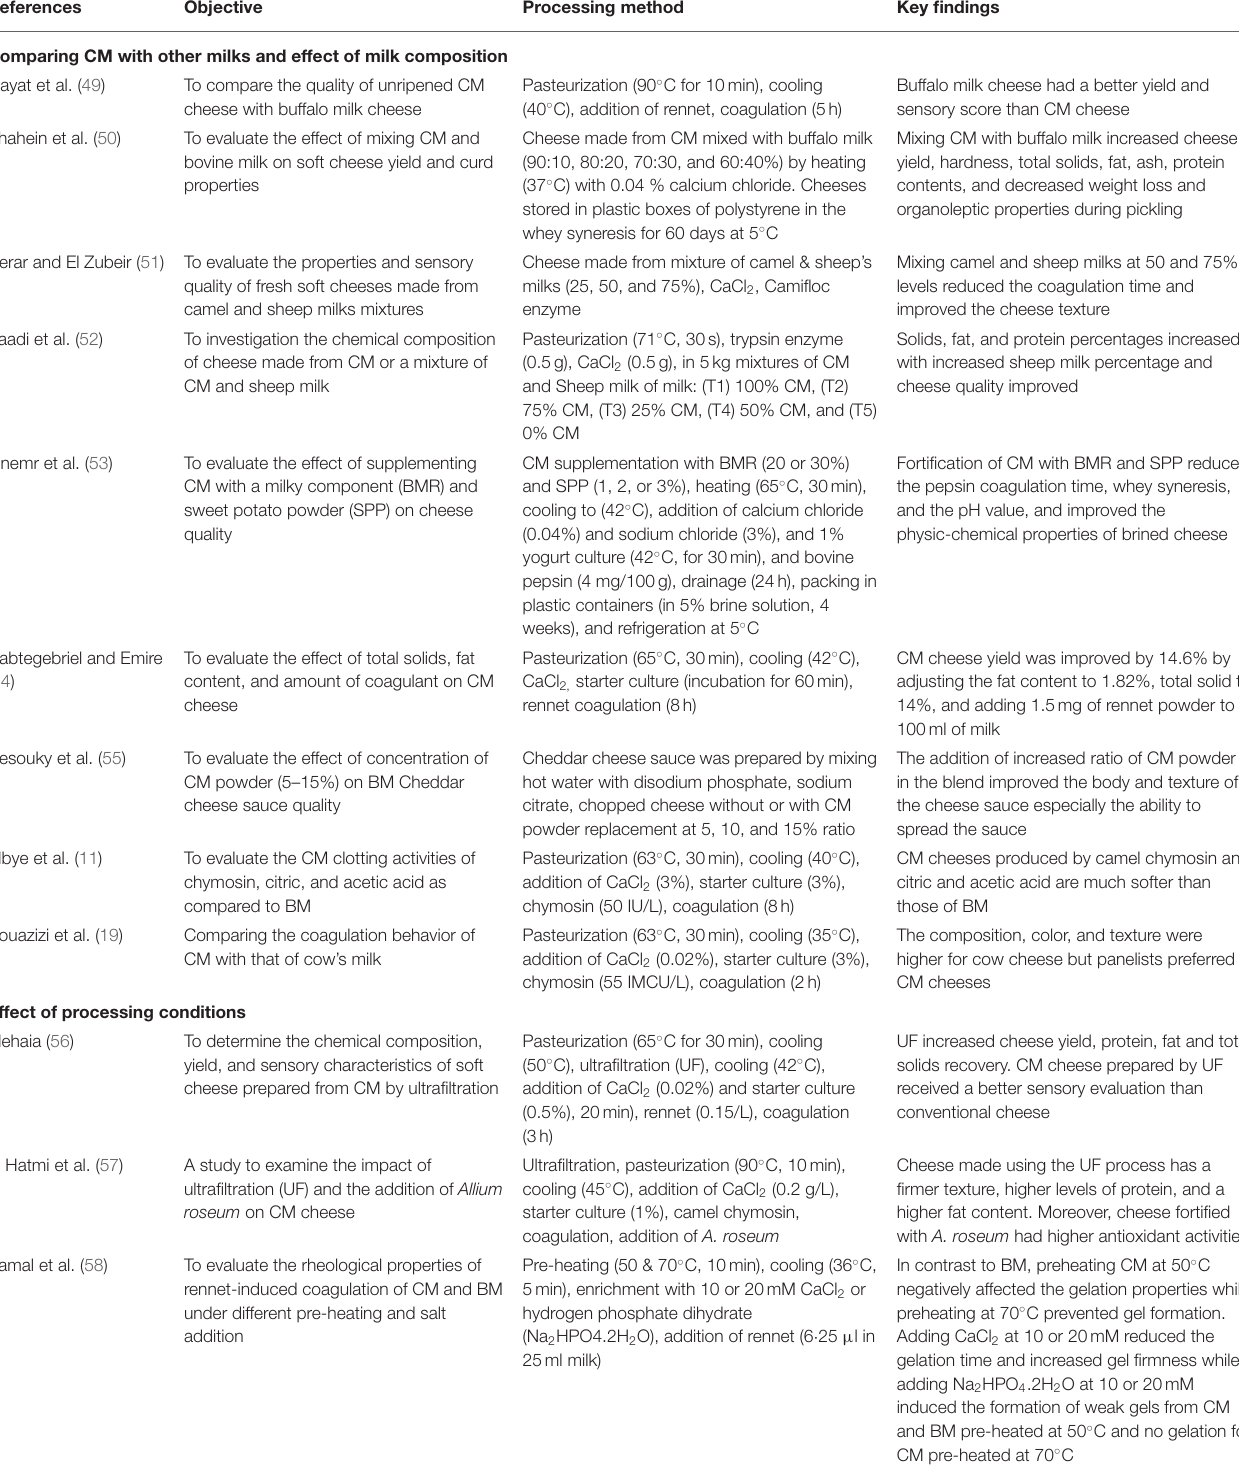
TABLE 3 | The effect of milk components, coagulants, and processing condition on the quality of CM